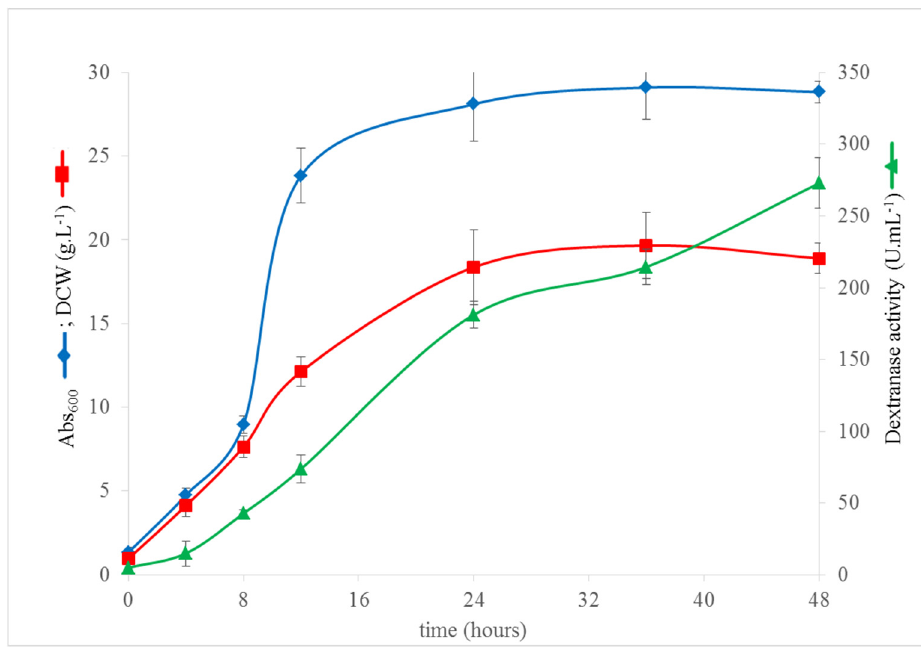
Figure 3. Cell growth and dextranase enzyme activity of K. phaffii DEX49A– Δ SP– Δ N30. Abs 600 , (DCW) values in g·L − 1 and dextranase activity (U·mL − 1 ) of the supernatant in 100 mL of YPG me- dium.